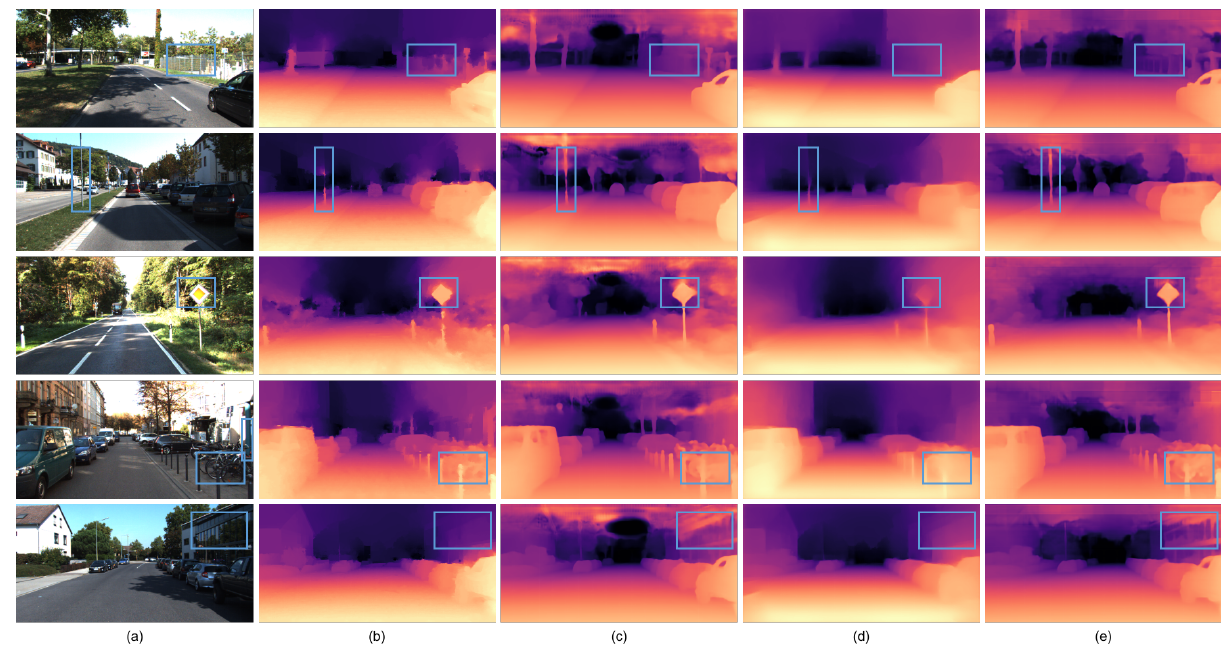
Figure 4. Qualitative examples on the KITTI Eigen test split. ( a ) RGB image; ( b ) ground truth; ( c ) Lee et al. [20]; ( d ) Alhashim et al. [67]; ( e ) Ours—ResNeXt101. The ground truth depth maps are filled based on sparse point clouds utilizing tools provided by the NYU Depth V2 dataset. For better visualization, the values of all the depth maps are logarithmic. Note that the encoders of Lee et al. [20] and ours are both ResNeXt101. Table 3. The quantitative results on the NYU Depth V2 dataset with Eigen split. Note that the best results of every metric among these works are marked in bold type, while the second best ones are underlined. We employ three encoders for our method, i.e., ResNet101, ResNeXt101 and DenseNet161. Metrics indicated by ↓ : lower is better; metrics indicated by ↑ : higher is